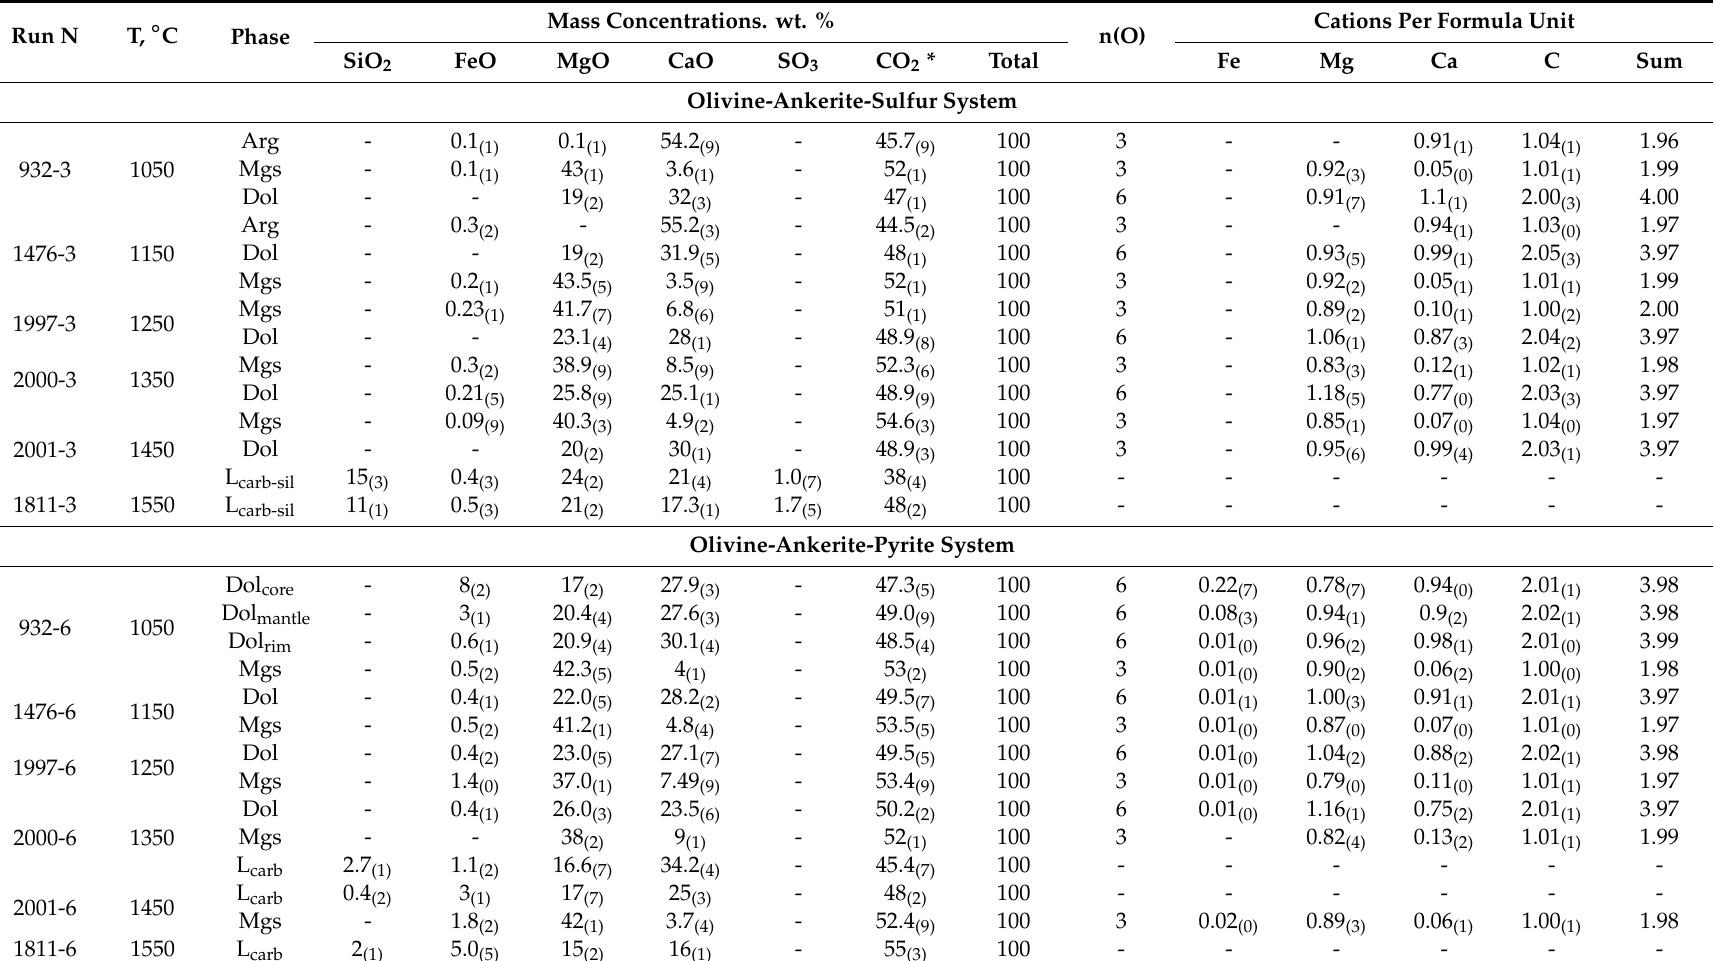
Table 4. Averaged compositions of carbonates and carbonate-based